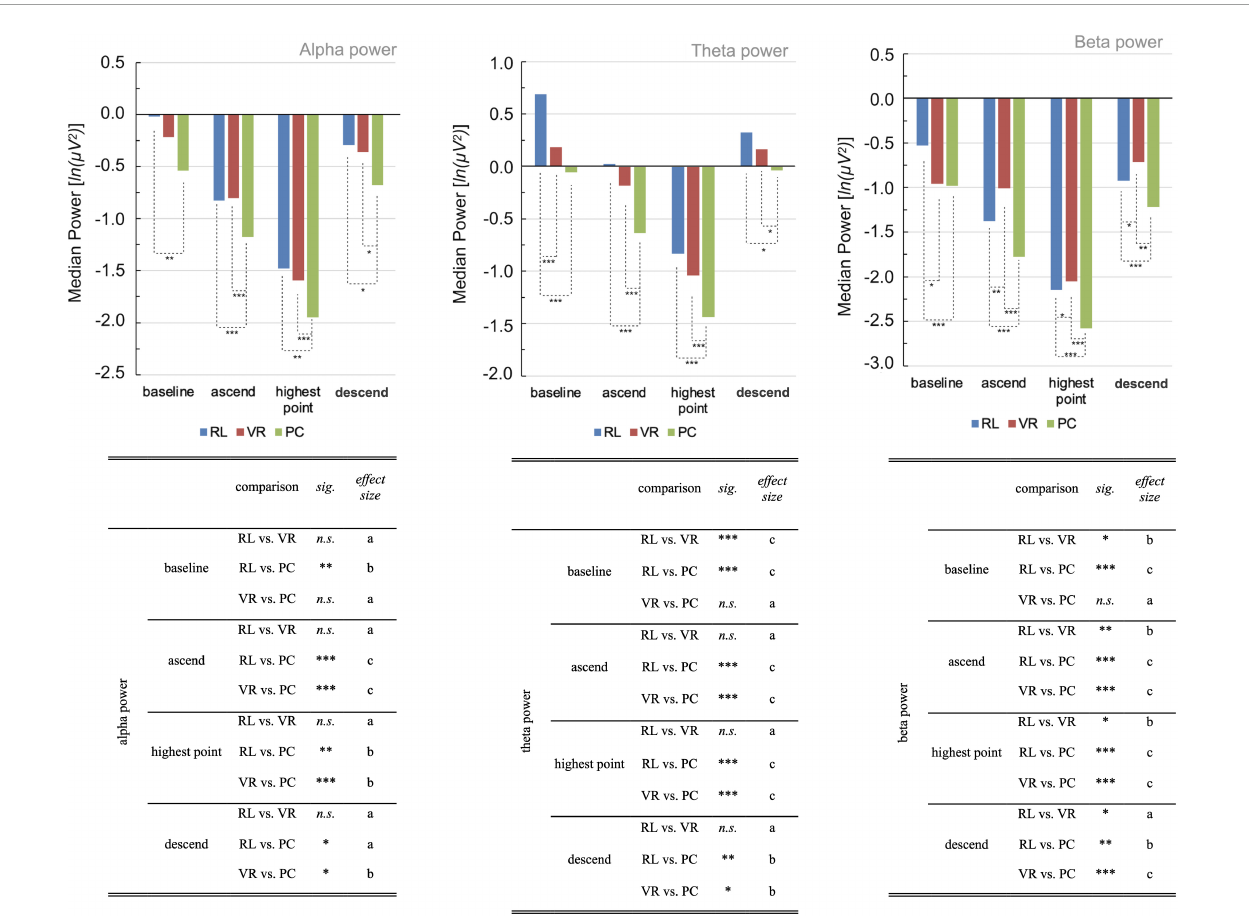
FIGURE3 Median band power [ln( µ V2)] per group, phase, and frequency band. Negative power values result from the logarithmic transformation during preprocessing: The logarithm of values greater than zero and smaller than one is negative. Hence, negative power values are to be read as smaller power compared to positive power values. The respective tables indicate the statistical characteristics per comparison in a reduced overview. Significant differences between groups are marked respectively (* p < 0.05, ** p < 0.01; *** p ≤ 0.001), and the effect size r is interpreted as follows: a, small effect; b, medium effect; c, large effect. Find a detailed report of all statistics in the Supplementary material